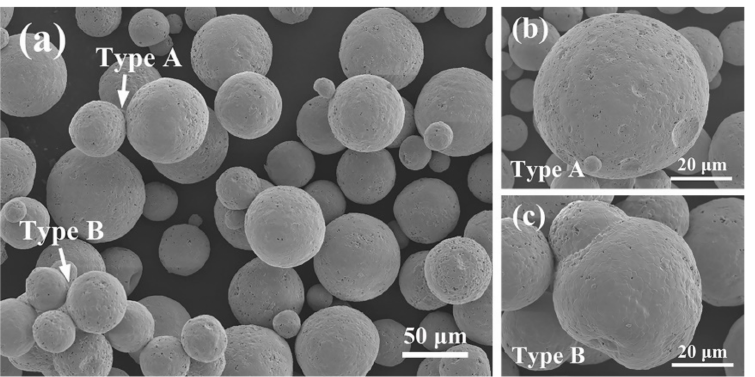
Figure 8. Surface morphologies of 10YGYZ agglomerated powders calcined at 1500 ◦ C for 3 h ( a – c ). Two types of sintering effects are illustrated by the enlarged images ( b , c